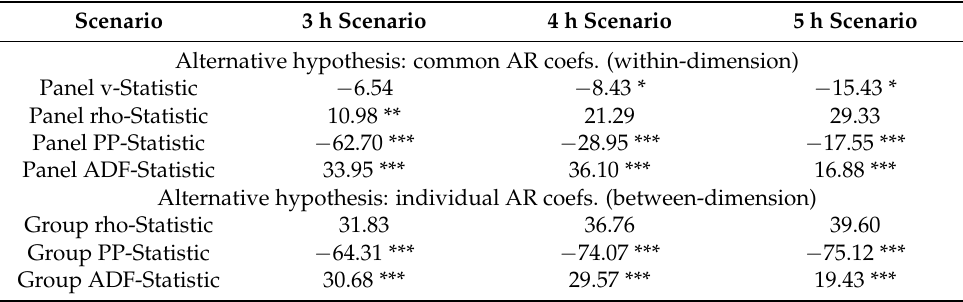
Table 3. Results of Pedroni cointegration